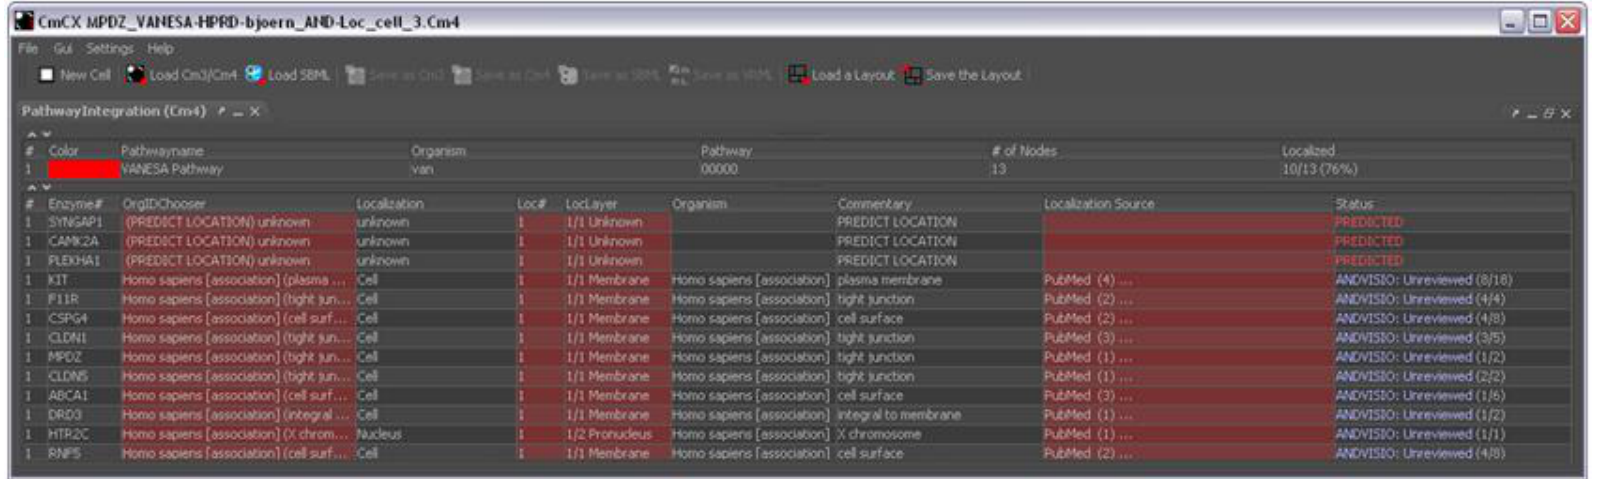
Figure 5: The localization of the MPDZ interacting protein network (Fig. 1) using CmPI and exclusively results from ANDVisio (Fig. 6): 4 proteins could be localized to the tight/cell junction, 4 proteins to the cell membrane, 2 proteins to the Nucleus and 3 proteins not at